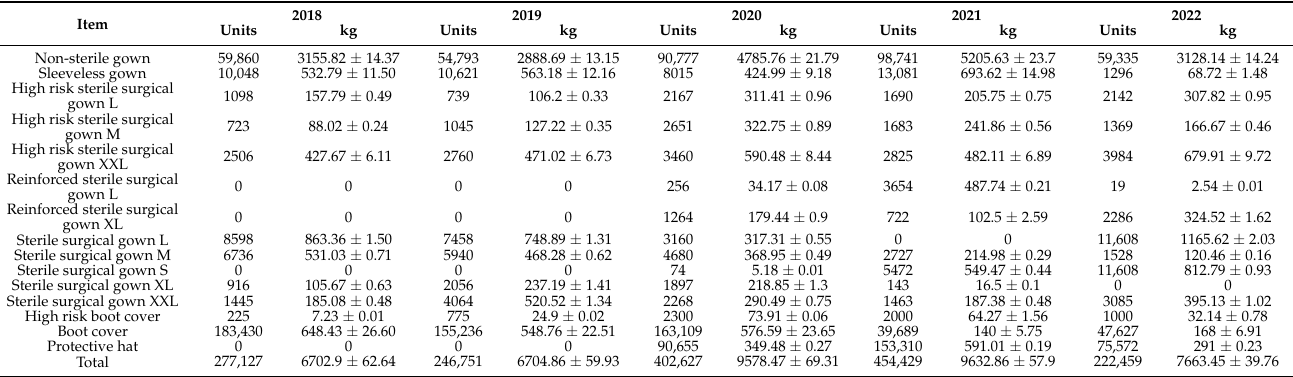
Table 2. Disposable nonwoven usage in the Francesc de Borja